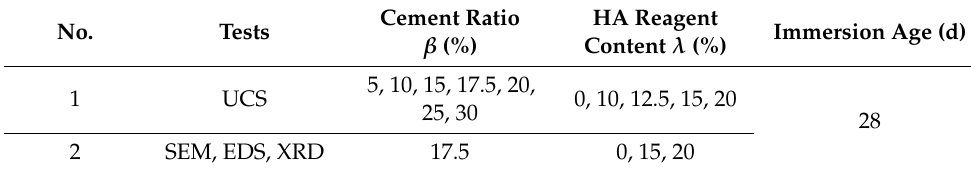
Table 2. Design of sample preparation.